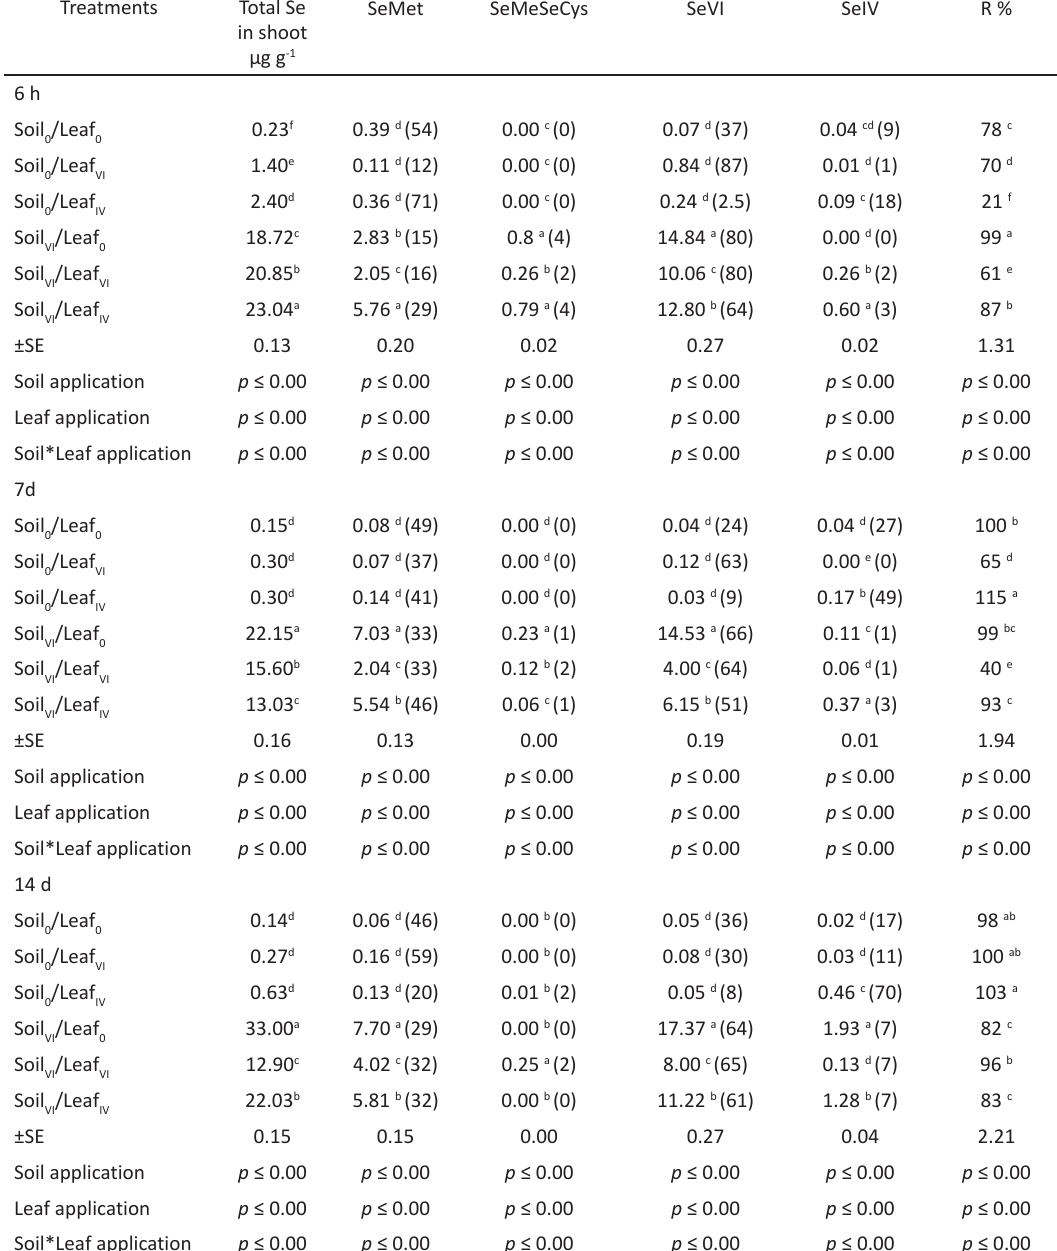
Table 1. The concentrations of total Se in shoot and different Se species (µg g -1 DM) in Brassica napus plants at 6 h, 7 days or 14 days after treatment with 0 or 130 µg Se plant -1 as Na SeO (Soil0 and SoilVI,) in soil and 0 or 30 µg Se plant -1 , foliar spray 2 4 of Na SeO or Na SeO , (Leaf0, LeafVI and LeafIV respectively). Selenomethionine (SeMet), selenomethyl selenocysteine 2 4 2 3 (SeMeSeCys) and inorganic SeVI and SeIV were detected. The recovery (R %) was calculated by ratio of the sum of Se species to the total Se obtained by the acid digestion method. The number inside brackets is the percentage of different Se species from total Se. Treatments Total Se in